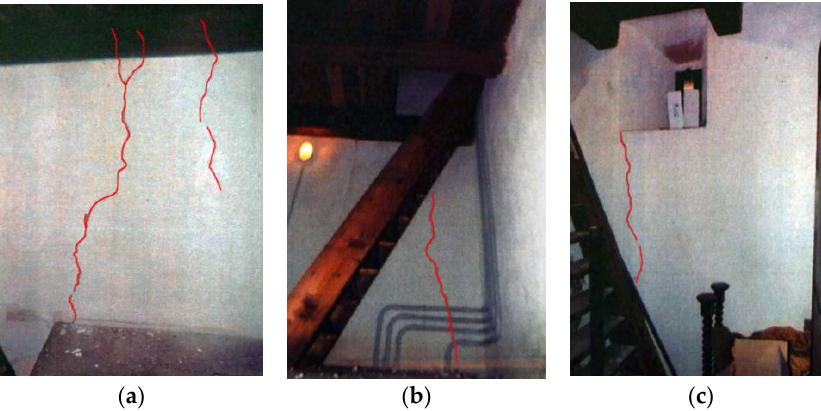
Figure 17. Interior state of damage of the bell tower. ( a ) Shear cracks of the ground floor [47]; ( b ) continuous part of the shear crack of the first floor [47]; ( c ) shear crack on the north side [47].